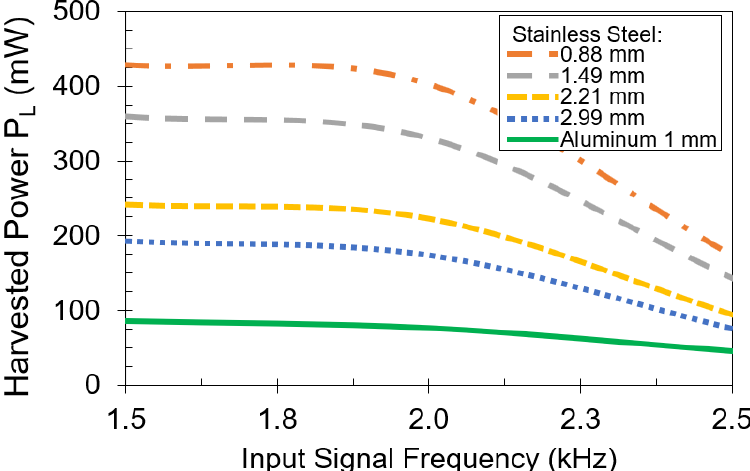
Figure 11. Harvested power versus frequency using stainless steel plates of different thicknesses. Input power is 3 W.